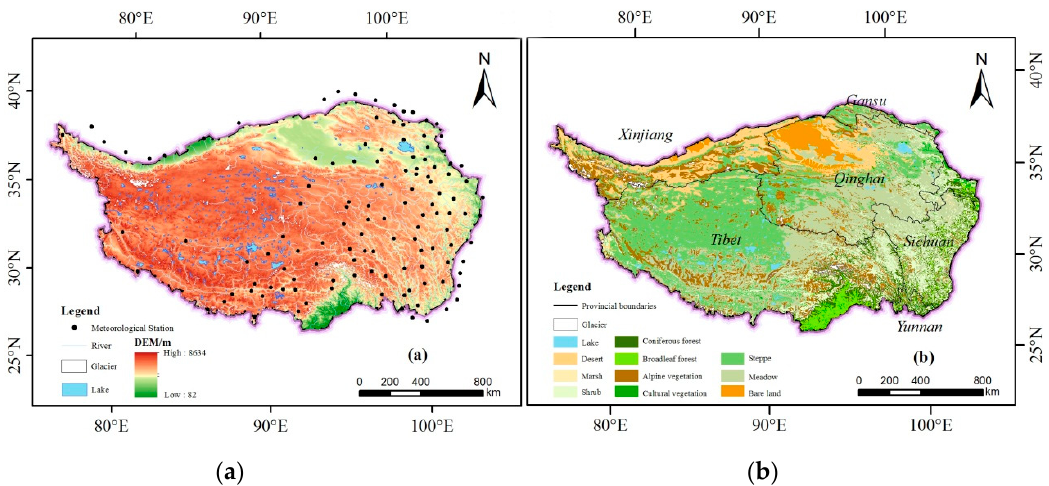
Figure 1. The Digital Elevation Model (DEM), meteorological station distribution ( a ) and the vegetation types ( b ) in TP.